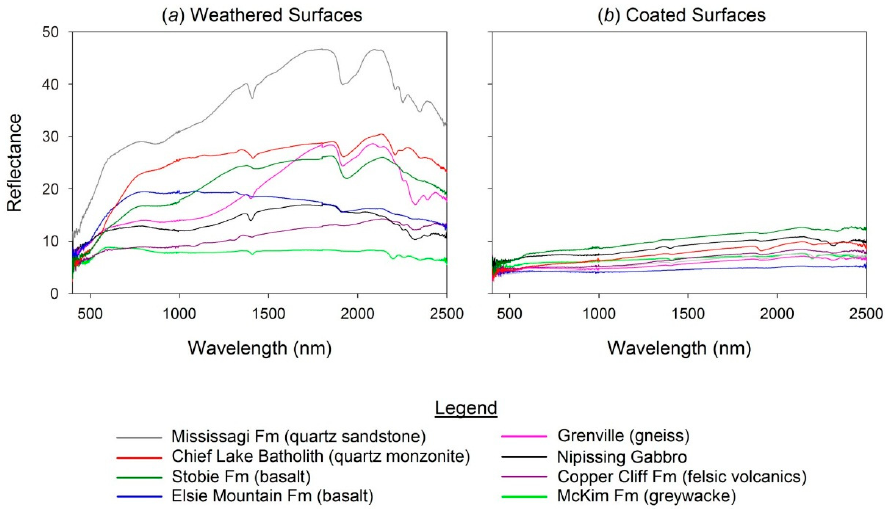
Figure 4. Sudbury bedrock units covered by black coatings are characterized by low albedo and an absence of prominent absorption features in reflectance spectra (after [8]). The above spectra are expressed as percentages and were measured at centimeter scale from Sudbury field samples over wavelengths of 400 to 2500 nm using a FieldSpec3 spectrometer equipped with a contact probe and integrated illumination source. ( a ) Weathered Surfaces; ( b ) Coated Surfaces.